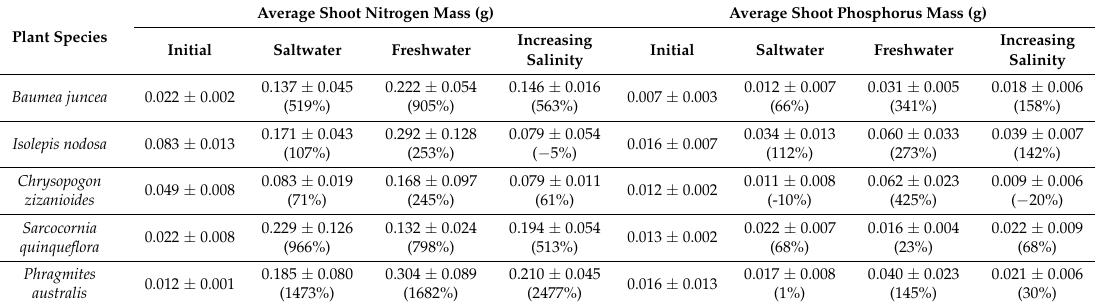
Table 2. Initial Tubestock Shoot Nutrient Mass and Final Shoot Nutrient Mass for Each Species in Each Water Treatment (Percentage Change in Shoot Nutrient Mass Shown in Brackets).